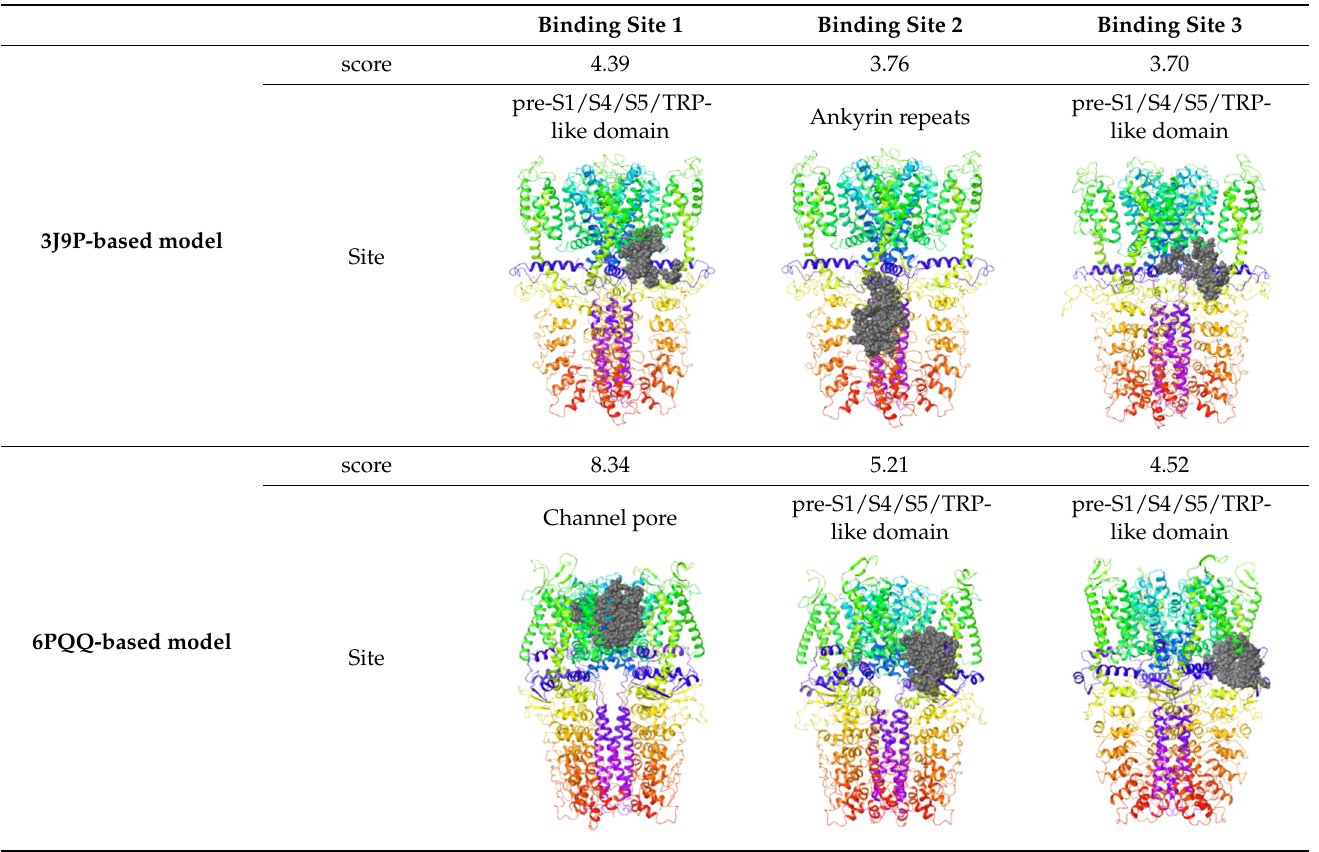
Table 4. Prediction of binding sites from Castp3.0 for models based on 3J9P and 6PQQ: number of sites and graphical illustration (red—the predicted sites).